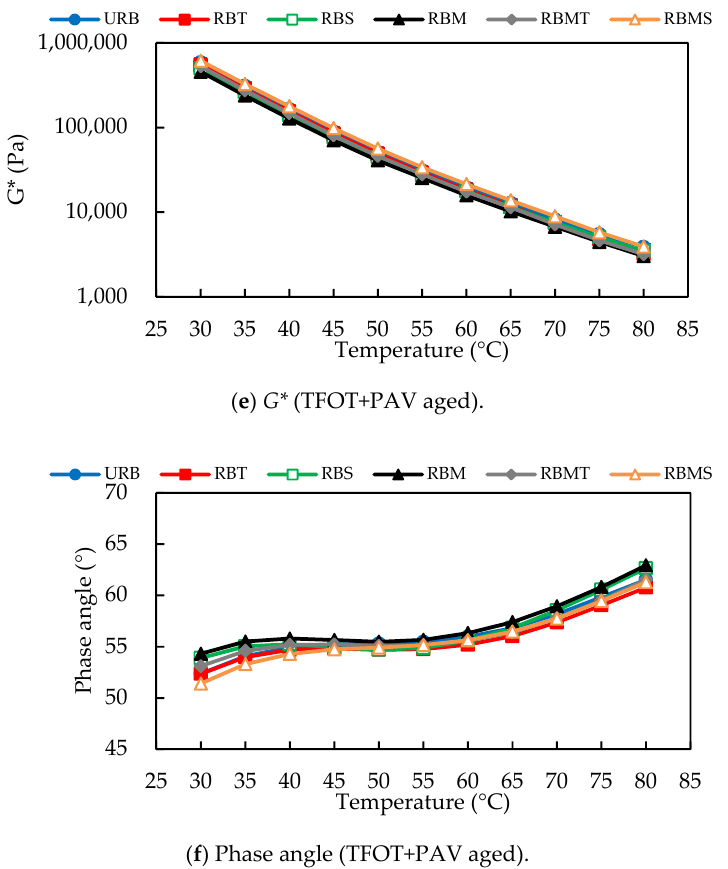
Figure 10. E ff ect of modification methods on the complex modulus and phase angles of rubberized bitumen depends on temperature sweep test.